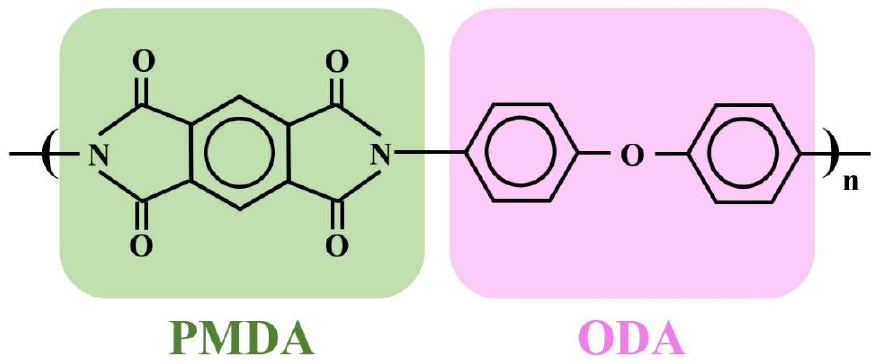
Figure 1. Structural formulas of